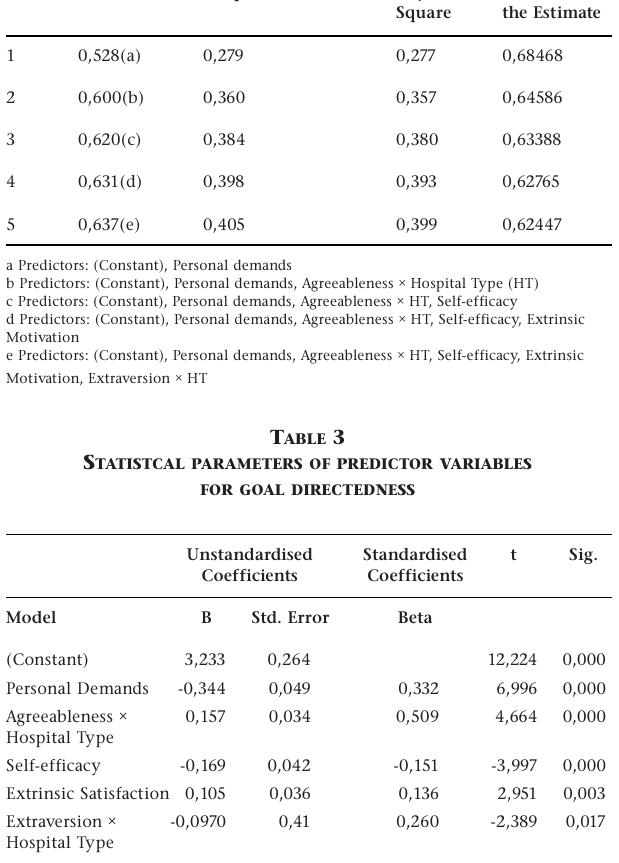
M ODEL SUMMARY FOR GLM : G OAL DIRECTEDNESS Model Summary Model